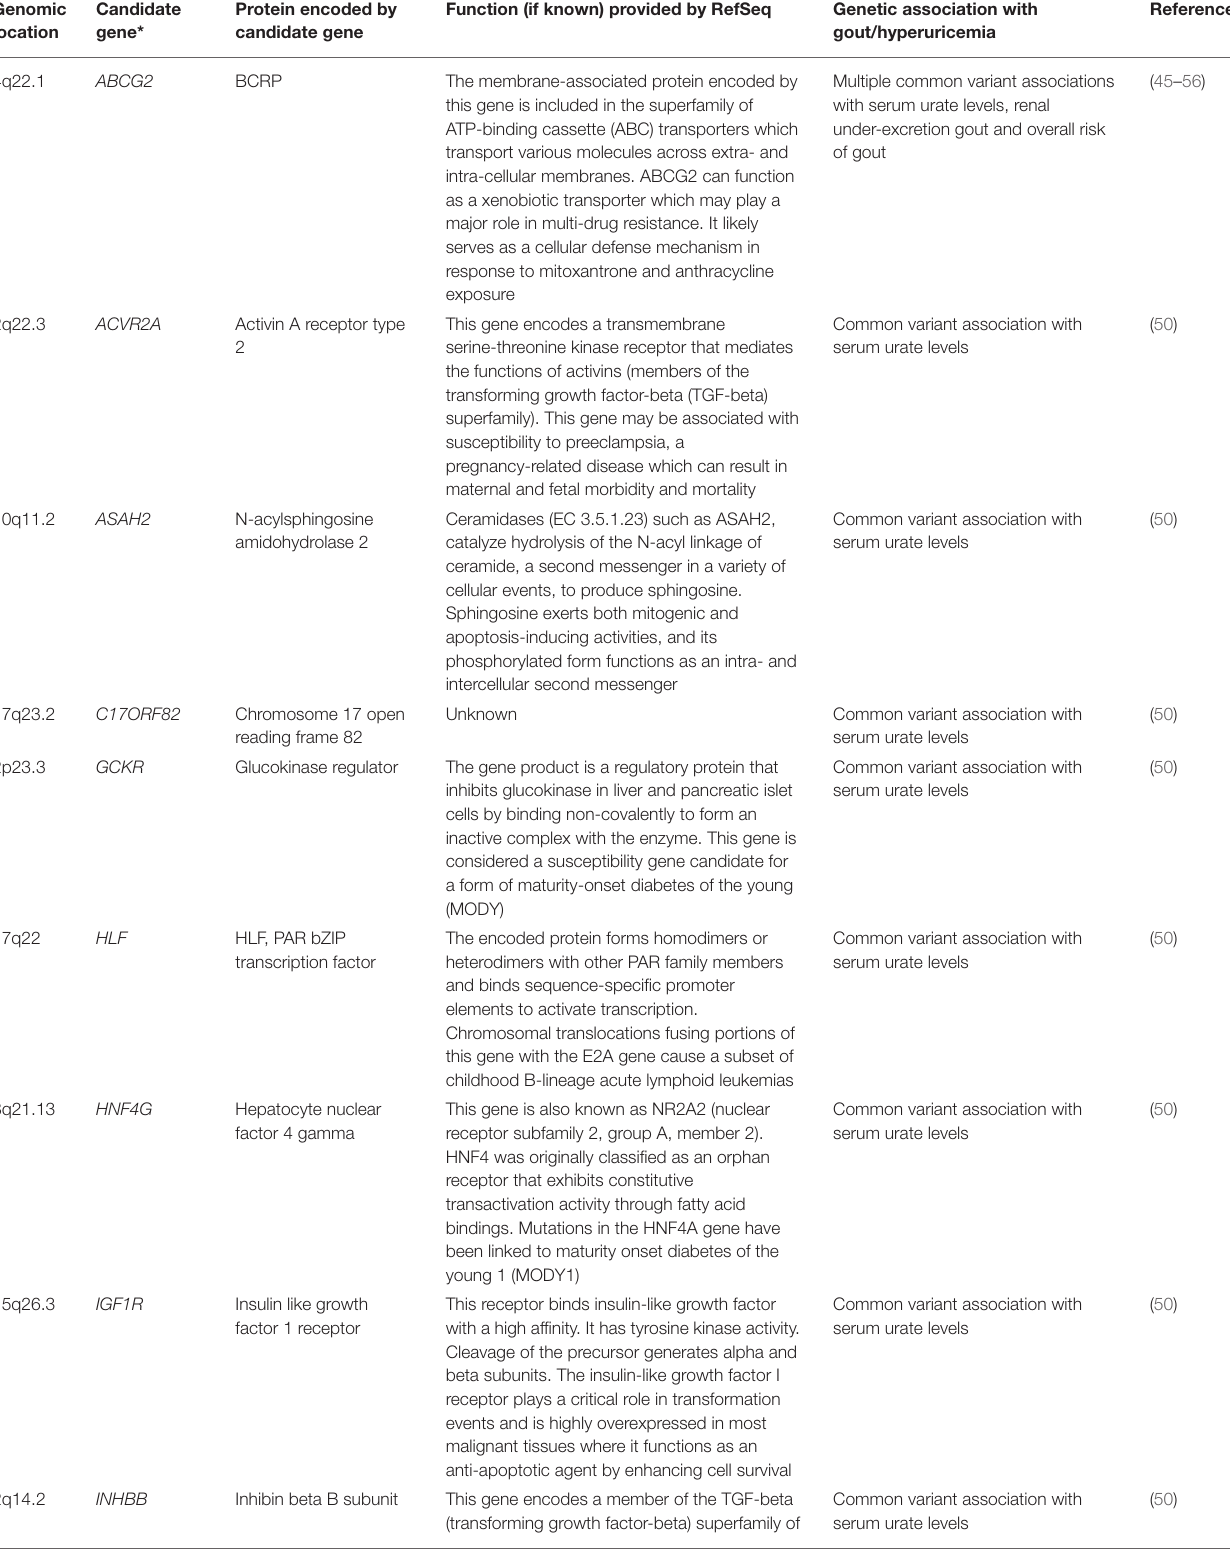
TABLE 1 | Genetic associations with urate levels. Genomic